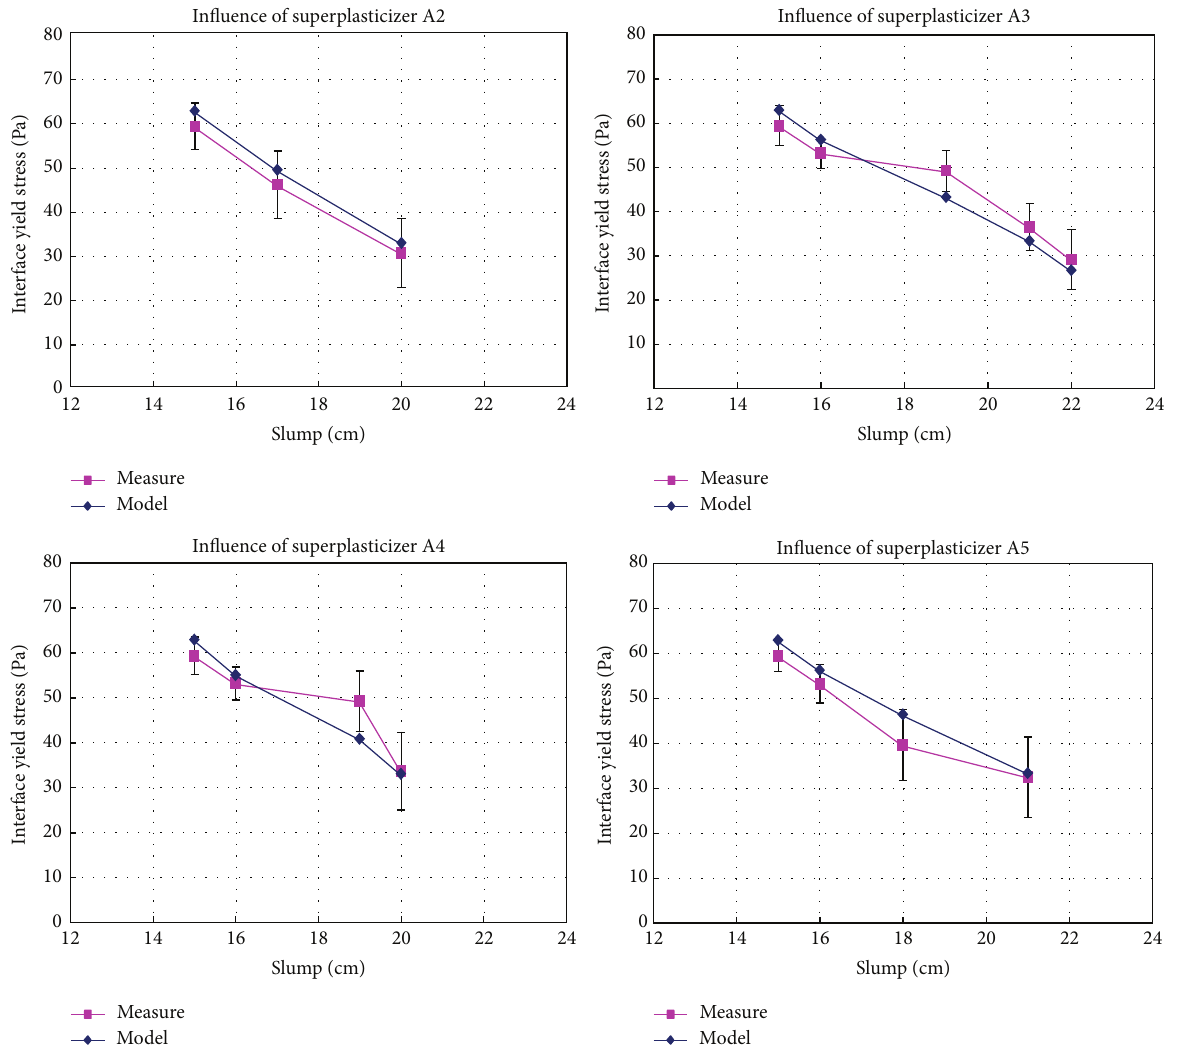
Figure 14: Comparison between the interface yield stress calculated by the model and the